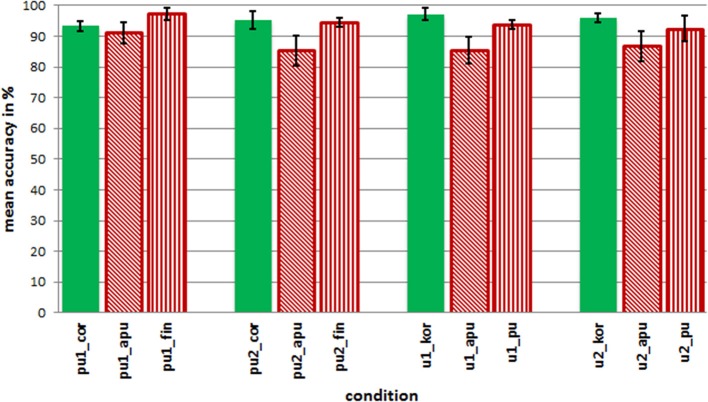
Mean accuracy in percent for each word type and condition.